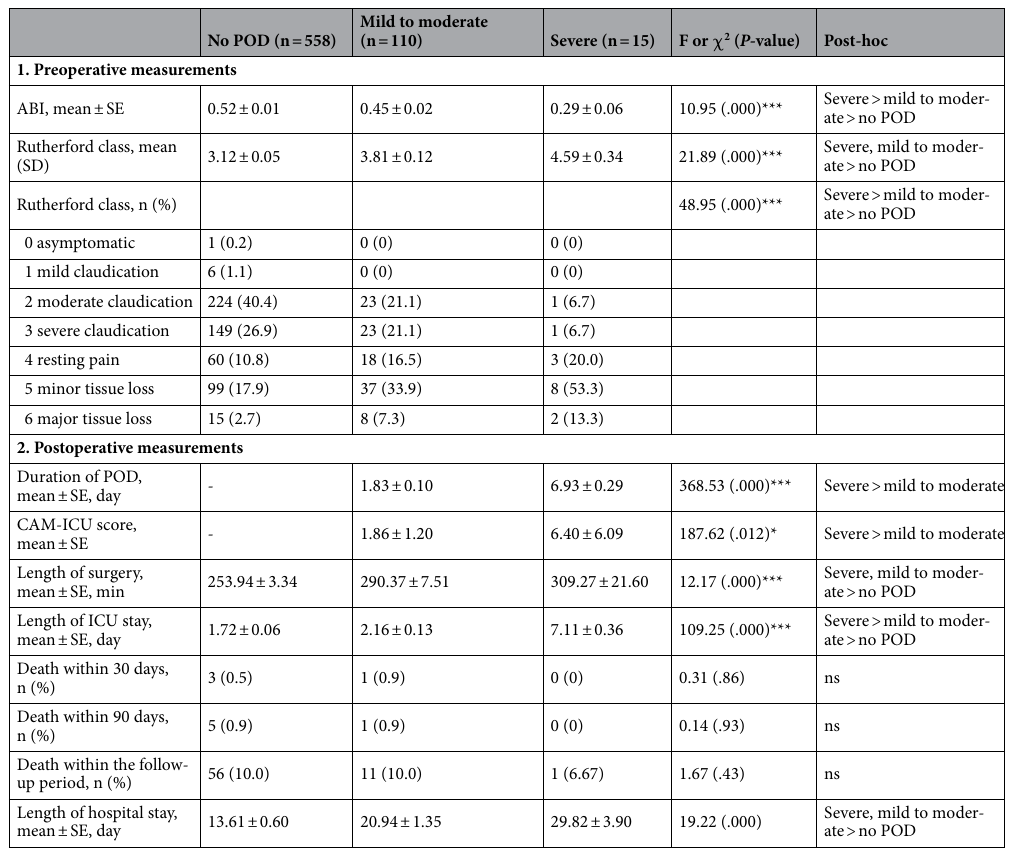
Table 2. Preoperative PAD measurements and postoperative outcomes. ABI ankle-brachial index, SD standard deviation, SE standard error, POD postoperative delirium, CAM-ICU confusion assessment method- intensive care unit. * P < .05, ** P < .01, *** P < .001.